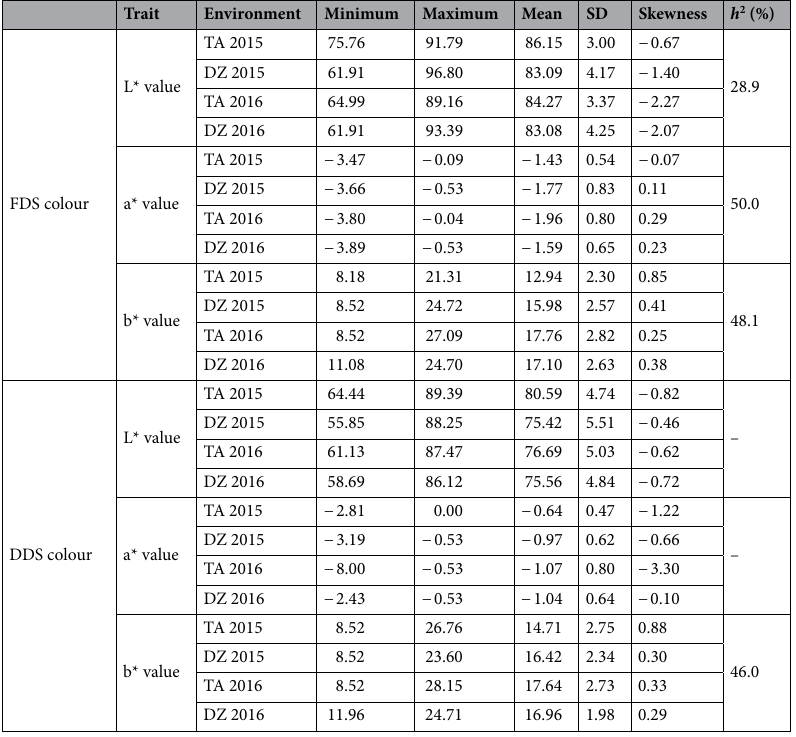
Table 2. Phenotypic analysis of fresh and dry dough sheet colour in two locations in 2 years. TA Tai’an location, DZ Dezhou location, L* value the brightness index, a* value the redness index, b* value the yellowness index, FDS fresh dough sheet, DDS dry dough